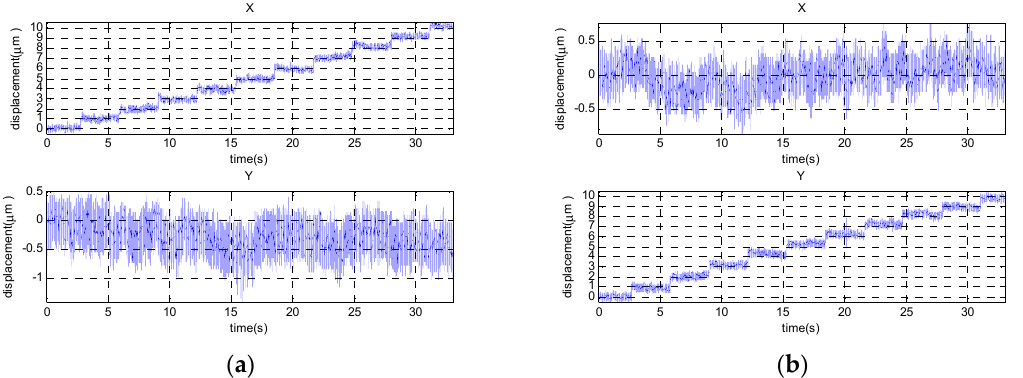
Figure 15. Verification of TCP − OMS resolution. ( a ) TCP moves along X − axis; ( b ) TCP moves along Y − axis.